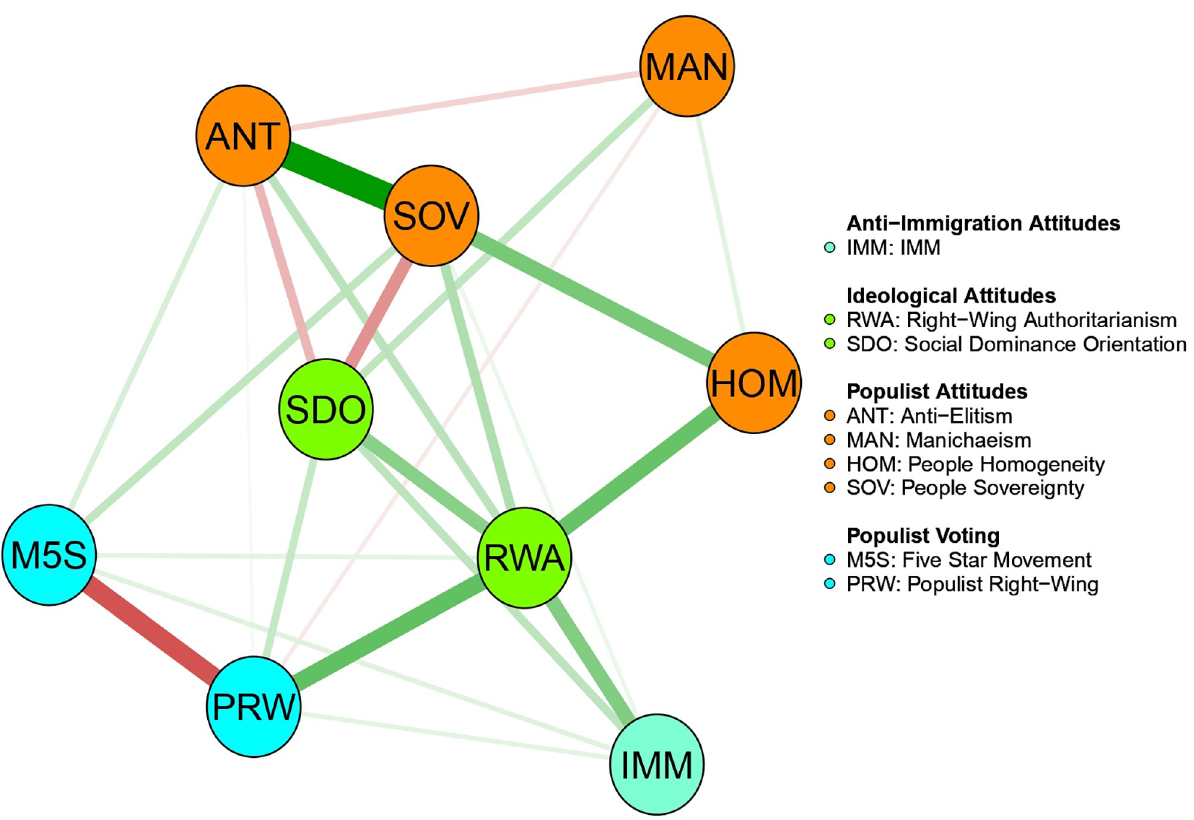
Fig 8. The Integrated beliefs system network. It reports the network model including Ideological attitudes, Anti-immigration attitudes, Populist Ideology and Voting.